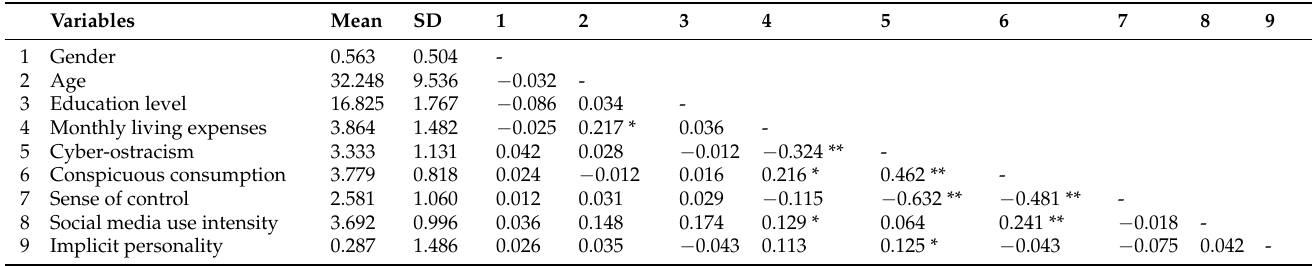
Table 4. Means, standard deviations, and correlation